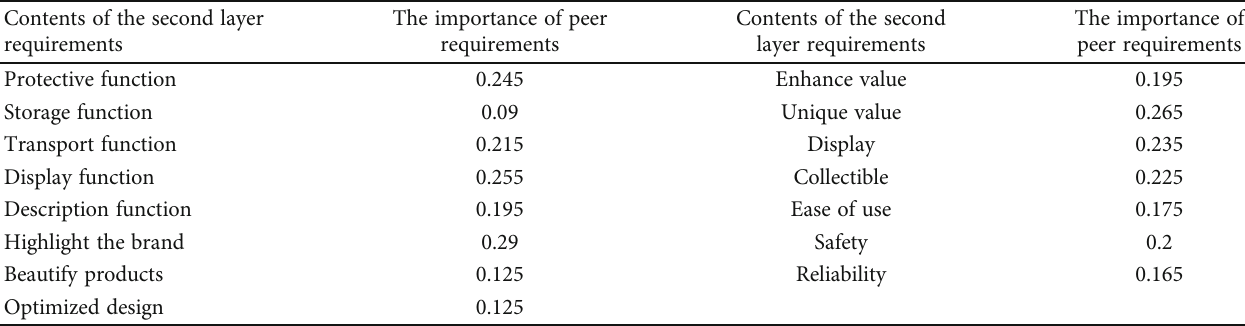
Table 5: The importance of peer-level requirements of the second-level requirements.